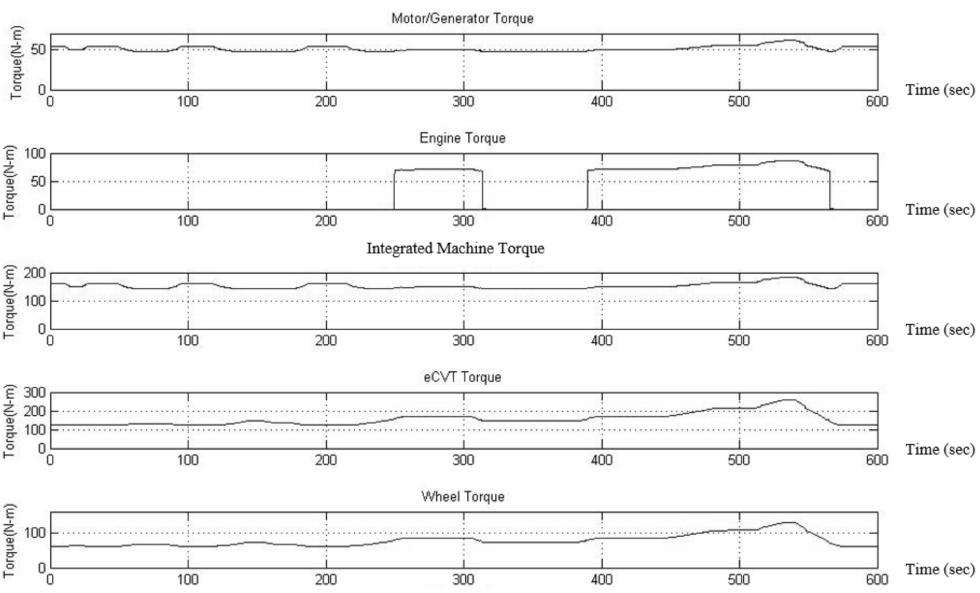
Figure 9. Output torque diagram of various components in the NEDC2000 driving cycle.